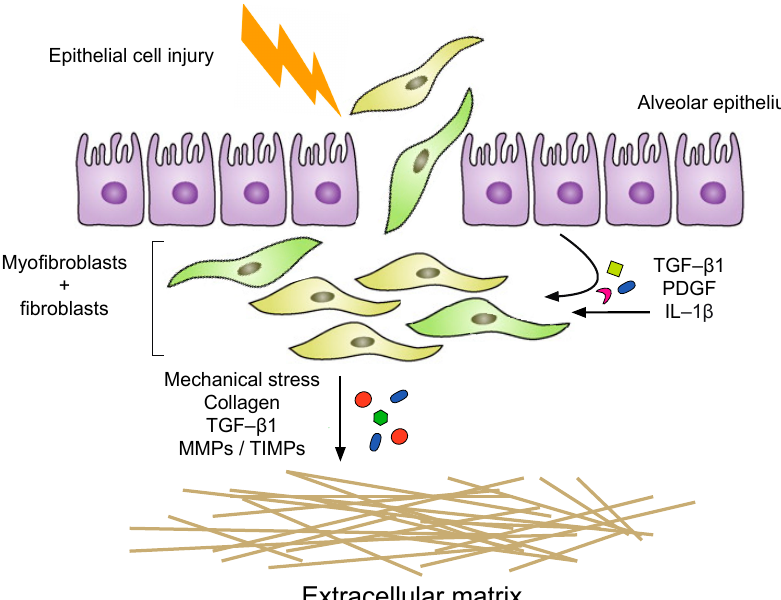
Figure 2. Pulmonary fibroblasts interact with the extracellular matrix to enhance the fibrotic response. During the fibrotic response, the alveolar epithelial cells undergo apoptosis due to injury which results in the infiltration of fibroblasts and myofibroblasts into the alveolar space. The dysregulation of fibroblasts is thought to be a critical player in the development of IPF where they excessively synthesize and release extracellular matrix components. The matrix is maintained by the presence of pro-fibrotic mediators released by the fibroblasts and other cells. The interactions of the fibroblasts and the ECM further enhance the fibrotic response in a positive-feedback loop.